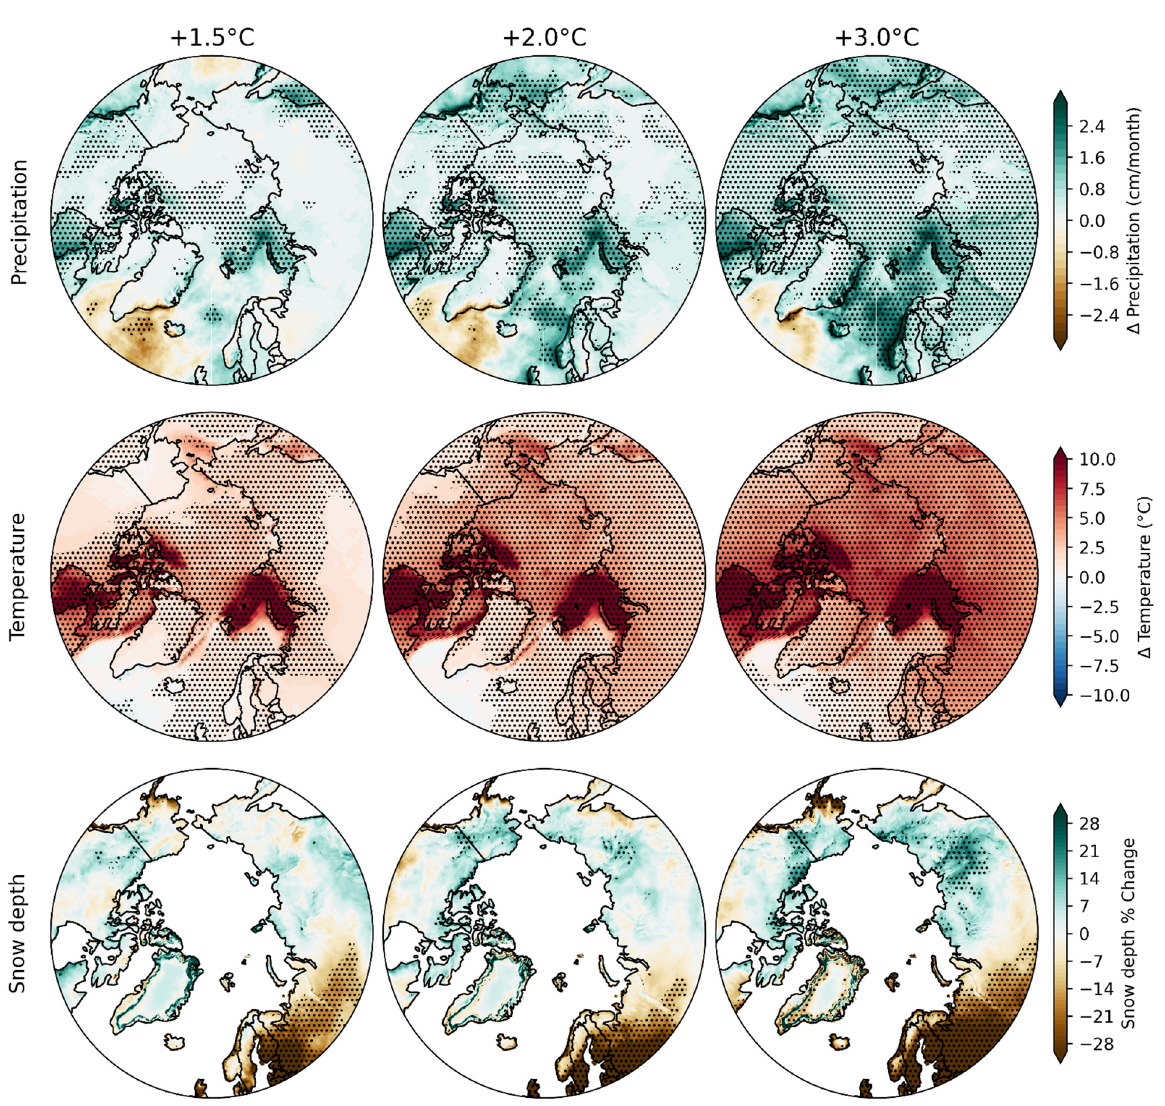
Figure 6. Percentage changes in December–February precipitation, cm/month (upper row); temper ‐ ature, °C (middle row) and snowfall, % change (bottom row) for stabilized global warmings of 1.5 °C (left column), 2.0 °C (middle column) and 3.0 °C (right column). Changes are relative to the means for the 1997–2015 period. Stippling denotes statistical significance at the 0.05 level.